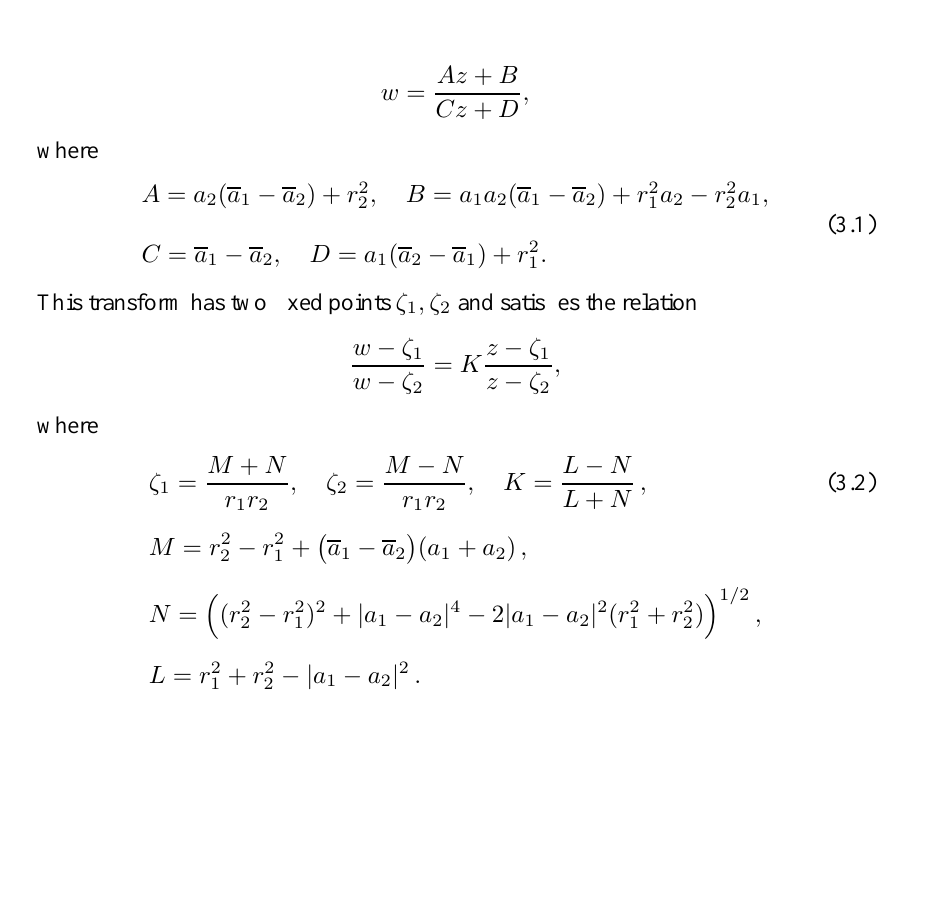
Figure 2. Symmetries with respect to two